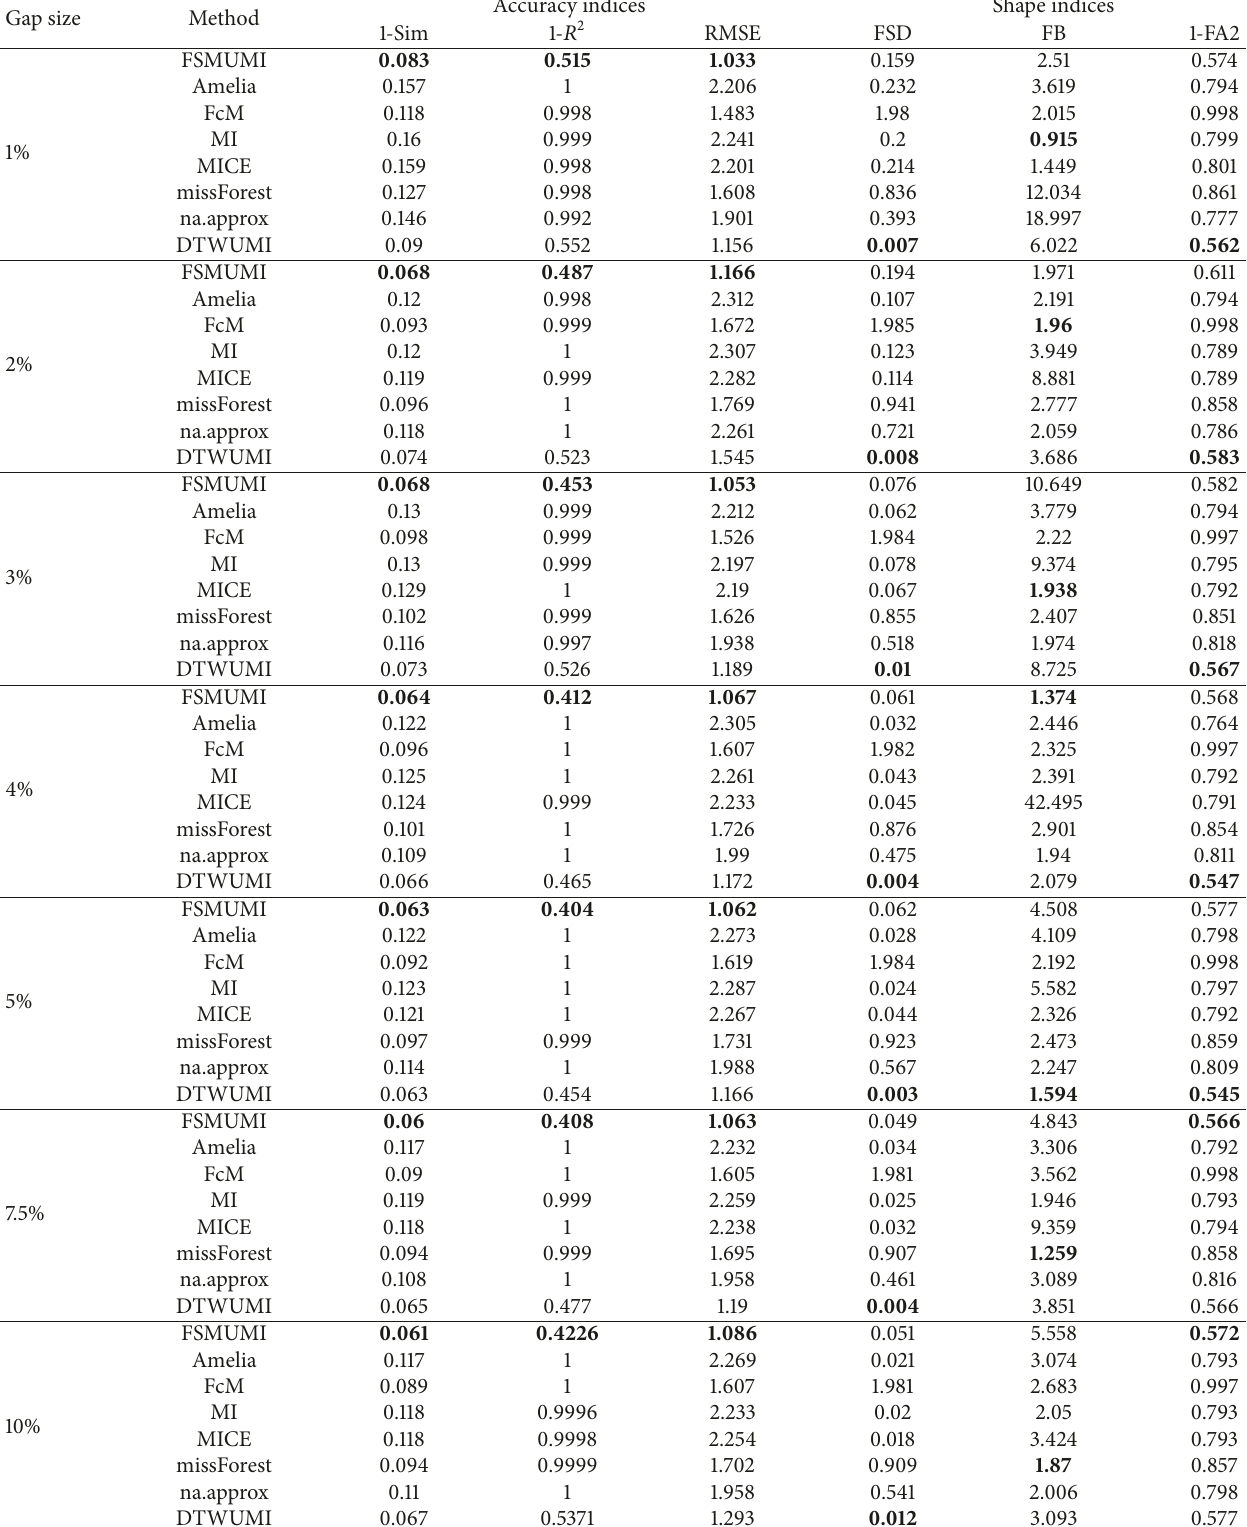
Table 2: Average imputation performance indices of various imputation algorithms on simulated dataset (32,000 collected